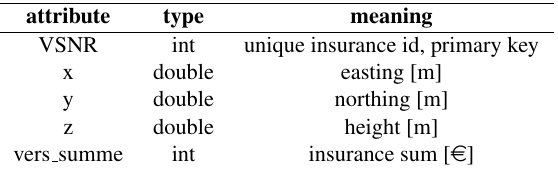
Figure 2 depict the distribution of the households in the test area. Cyan dots mark households which own an insurance, red dots mark the households which were affected by an damage event.